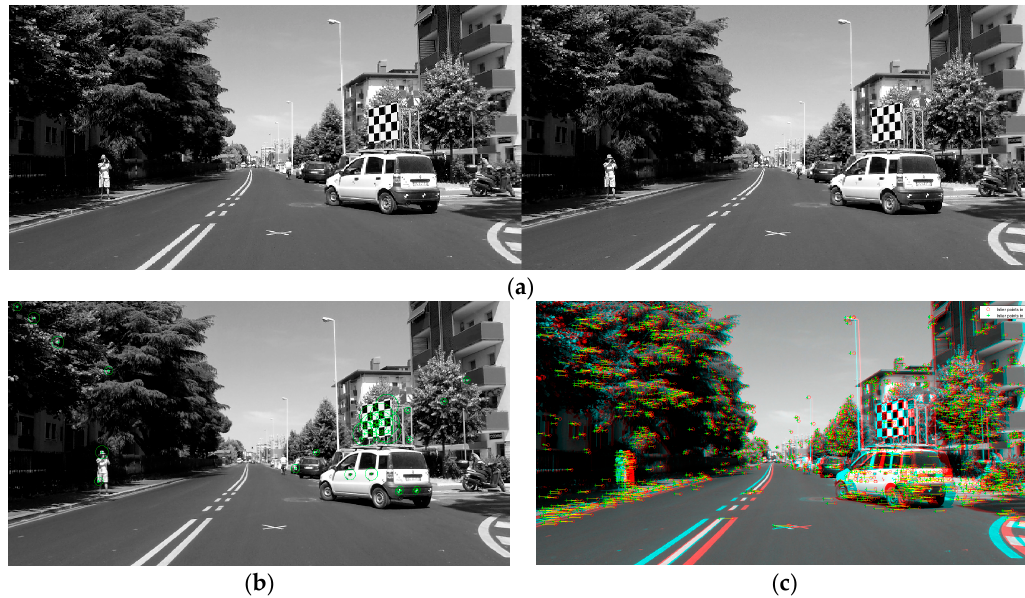
Figure 7. Illustration of the automatic camera extrinsic parameters re-calibration. ( a ) An initial rectification of the stereo frame according to the static calibration values; ( b ) SURF feature extraction in both images of the stereo pair (circle’s diameter represents the scale of the feature); ( c ) The salient features matched (correct pixel assignments indicated by yellow connections) are overlaid on a 3D anaglyph.